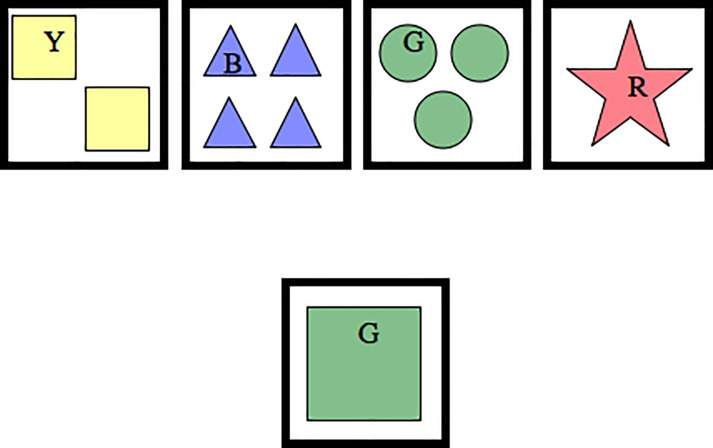
Example of three and four-target condition.Both the three and four-target levels included three possible sorting rules: colour, shape, or number. The three-target condition contained the one red star, two yellow squares, and three green circles. The four-target condition contained these same three targets plus the four blue triangles. The one green square test card can be matched to the two yellow squares when the rule is shape, to the three green circles when the rule is colour, and to the one red star when the rule is number.